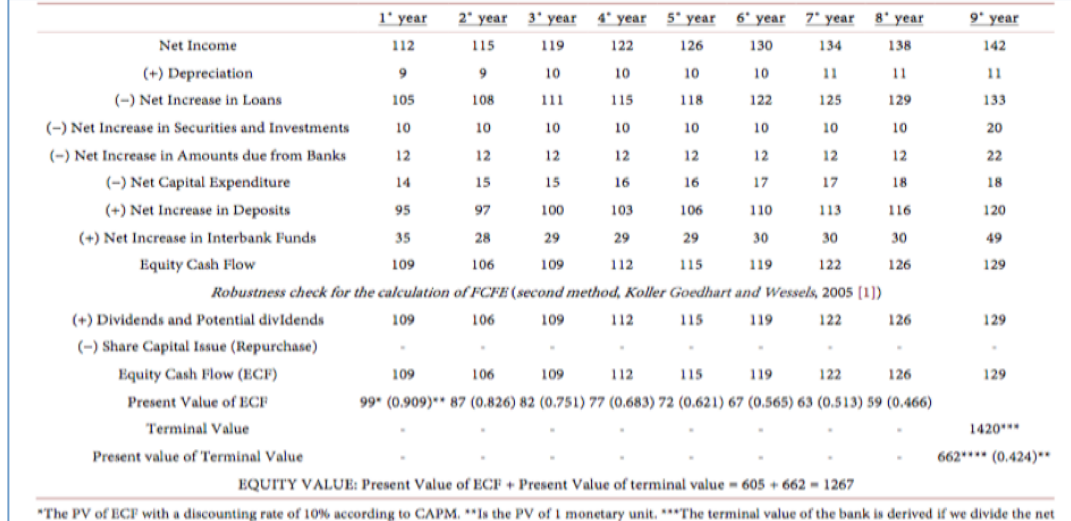
Table 1: Calculation of Equity Value using FCFE